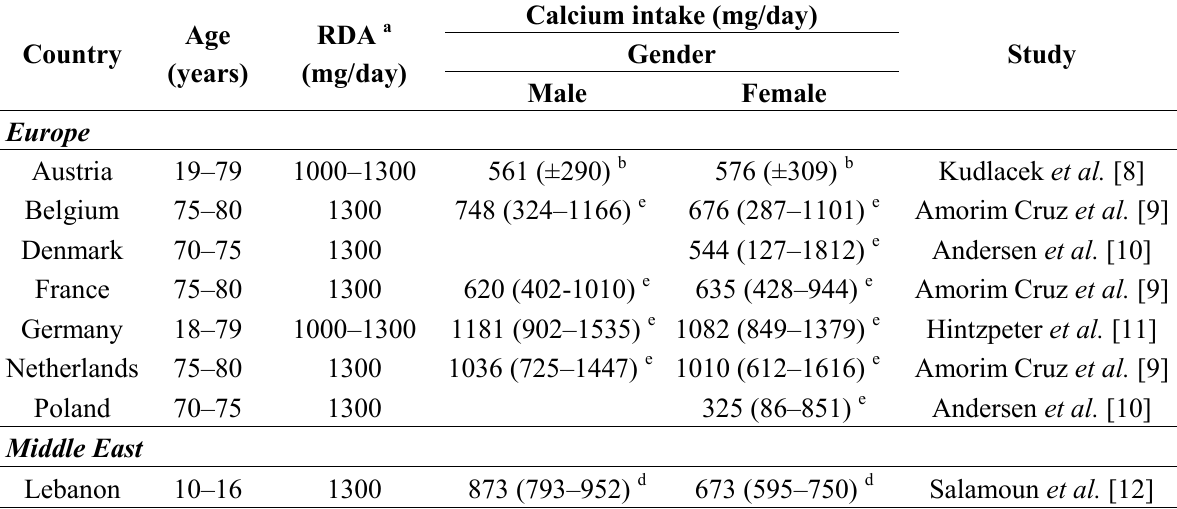
Table 1. Actual and recommended dietary calcium intake in different population groups of selected